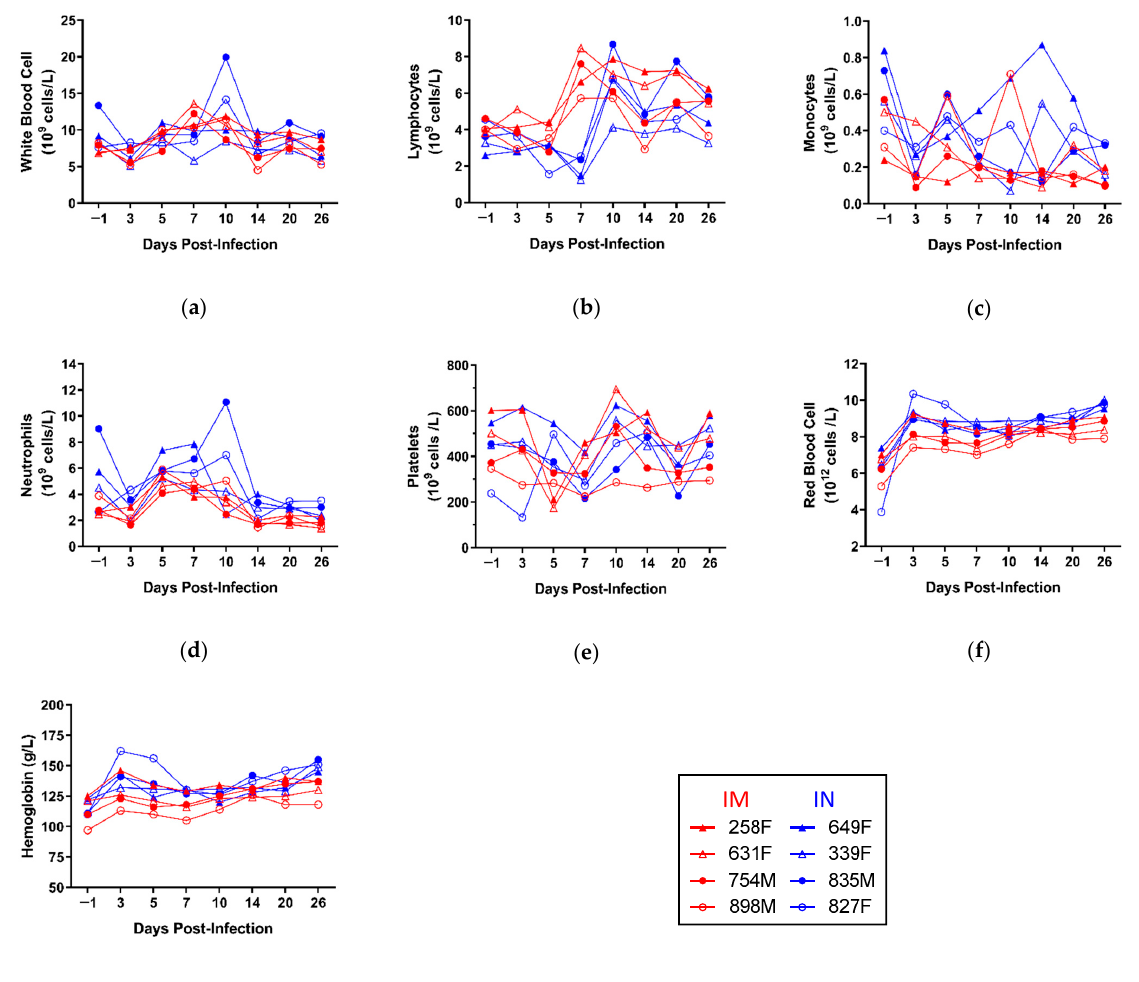
Figure 4. Complete blood counts of TAFV-infected ferrets. Whole blood was collected from each animal on days − 1, 3, 5, 7, 10, 14, 20, and 26 post-infection and the concentrations of the following analytes measured: ( a ) white blood cells (WBC); ( b ) lymphocytes (LYM); ( c ) monocytes (MON); ( d ) neutrophils (NEU); ( e ) platelets (PLT); ( f ) red blood cells (RBC) and ( g ) hemoglobin (HB). Individual animal IDs and sex (F/M) are indicated in the key. IM, intramuscular inoculation; IN, intranasal inoculation.